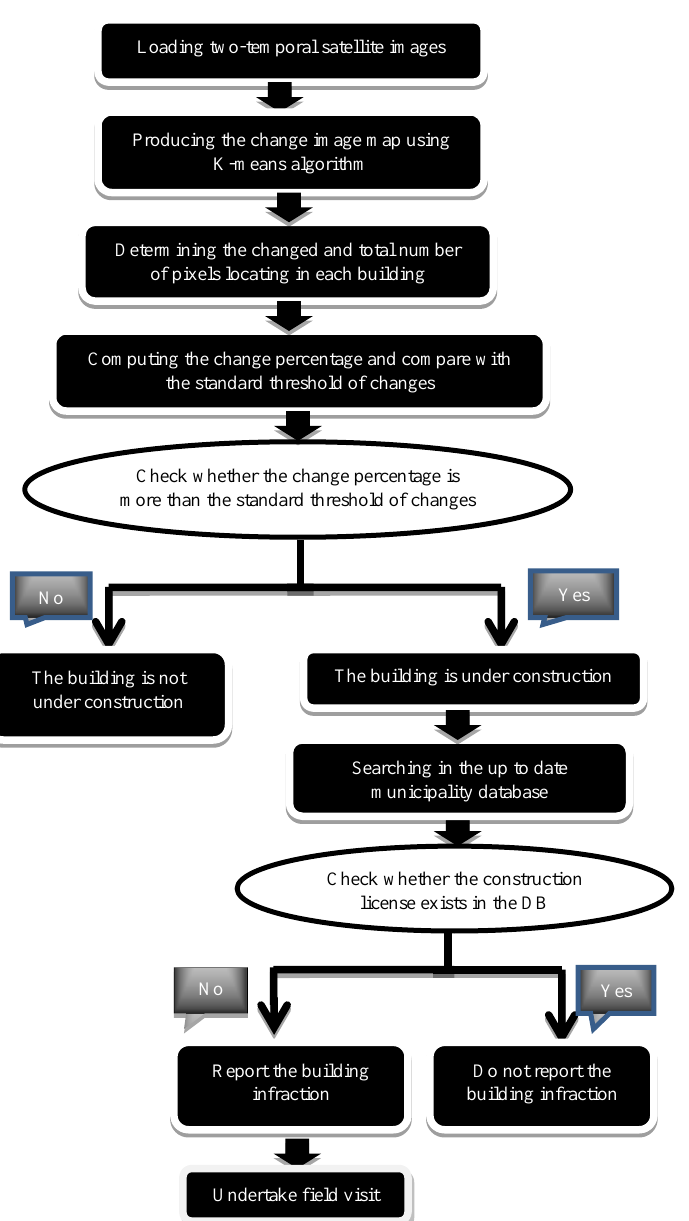
Figure 1. Steps to detect the illegal buildings In the next step, the squared Euclidean distance from each